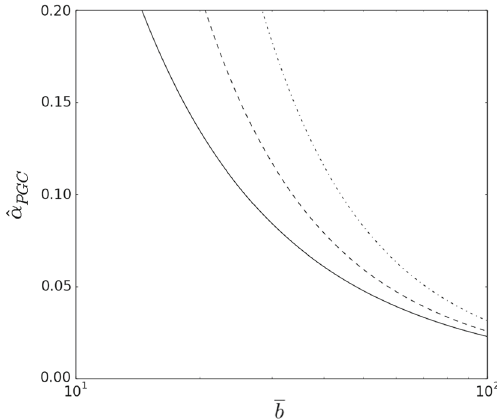
Fig. 11 Plot of ˆ α PGC vs. b for Λ = 1 (continuous line), Λ = 0 . 25 (dashed line), and Λ = 0 . 1 (dot-dashed line). We used, (cid:22) J r = 0 . 25,